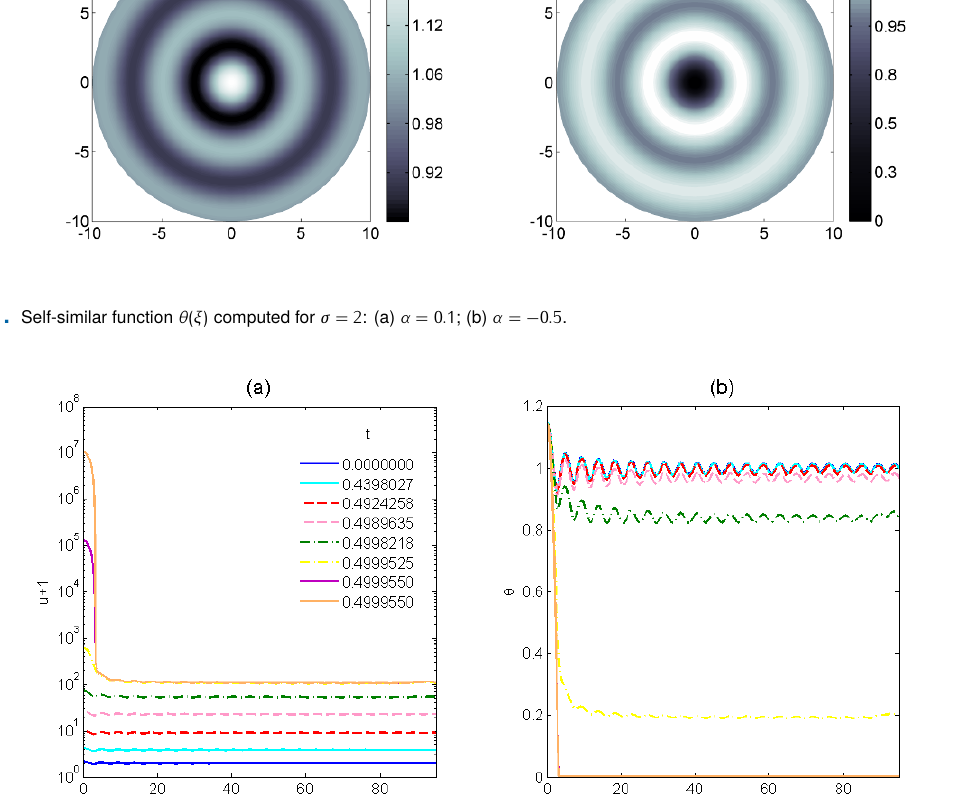
( t,r ) from Example 2.1 and its self-similar representations.